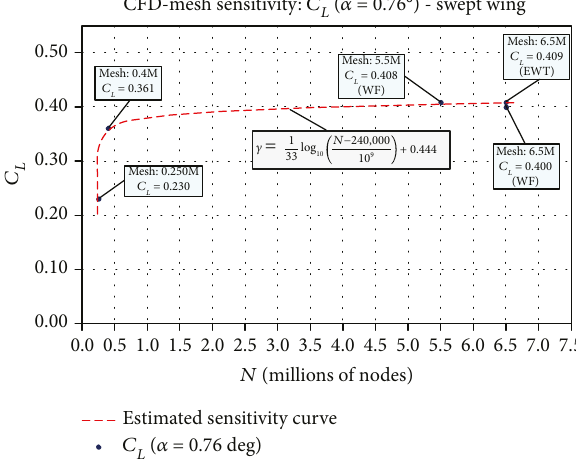
Figure 18: CFD mesh sensitivity — C